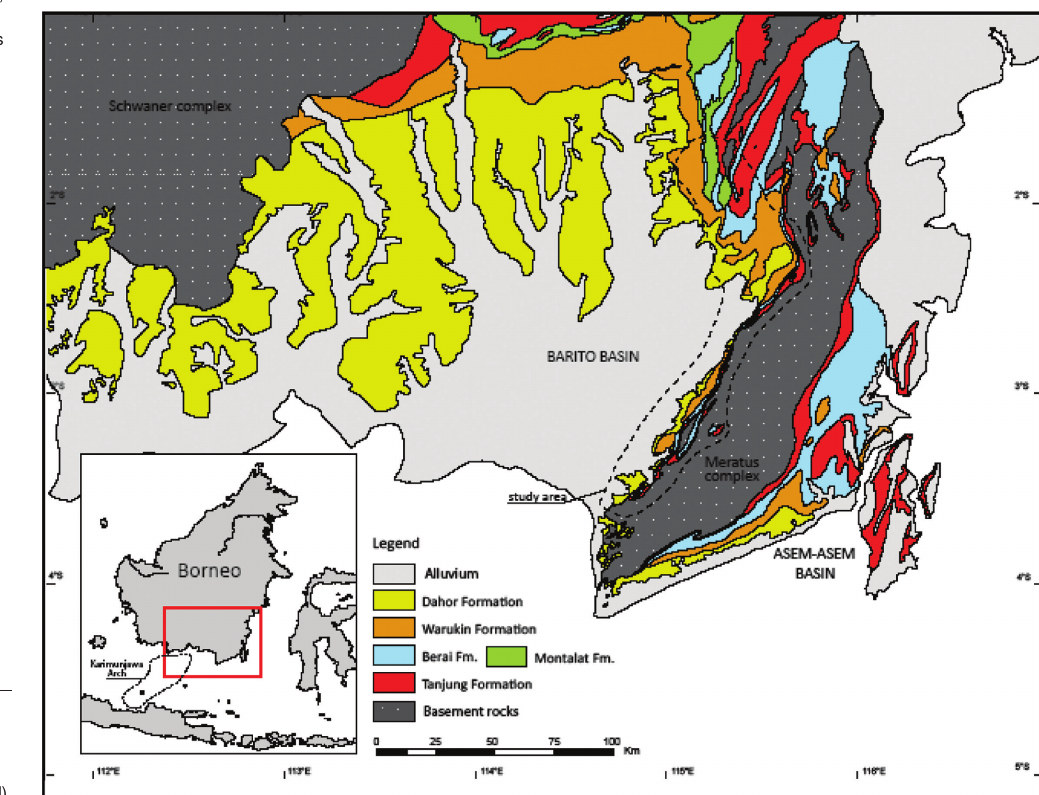
Cenozoic geology of the Barito and Asem-Asem Basins (modified from [61]).